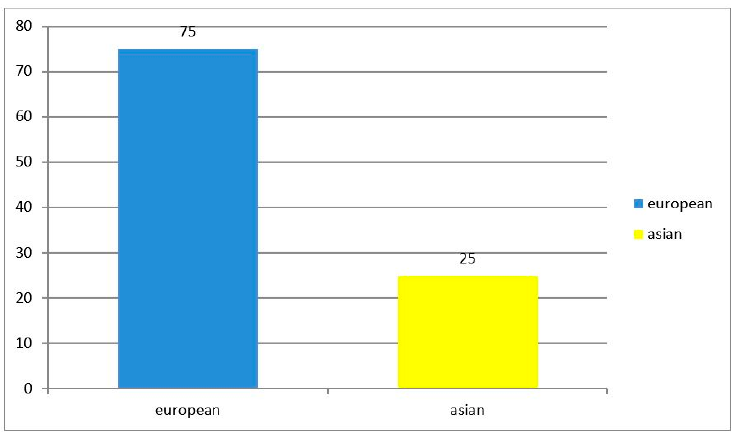
Figure 2. Prevalence of D. repens infections in the European and Asian parts of Russia (1997–2012).